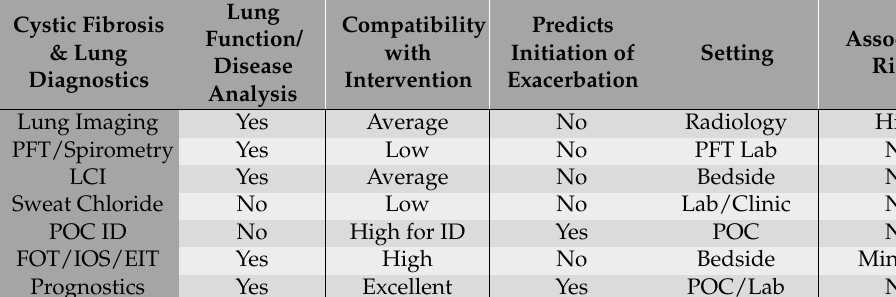
Table 1. Currently used and emerging cystic fibrosis & lung disease diagnostic comparison. PFT: Pulmonary Function Test, LCI: Lung Clearance Index, POC ID: Point of Care Infectious Disease, FOT: Forced Oscillation Technique, IOS: Impulse Oscillometry System, EIT: Electrical Impedance Tomography.